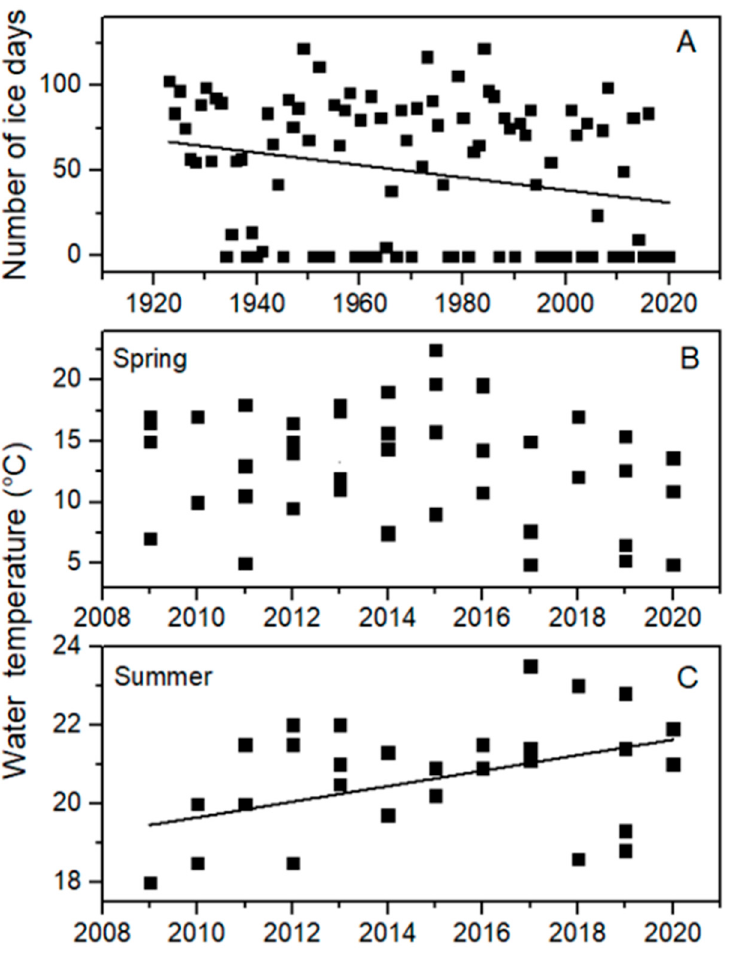
Figure 2. ( A ) Number of ice days, ( B ) surface water temperature in spring (April–June) and ( C ) surface water temperature in summer (July–August) in Bear Lake. Trends were significant for numbers of ice days (linear curve fit: y = − 0.368x + 774, R 2 = 0.06, p = 0.011) and water temperature in summer (linear curve fit: y = 0.198x − 378, R 2 = 0.18, p = 0.0096).